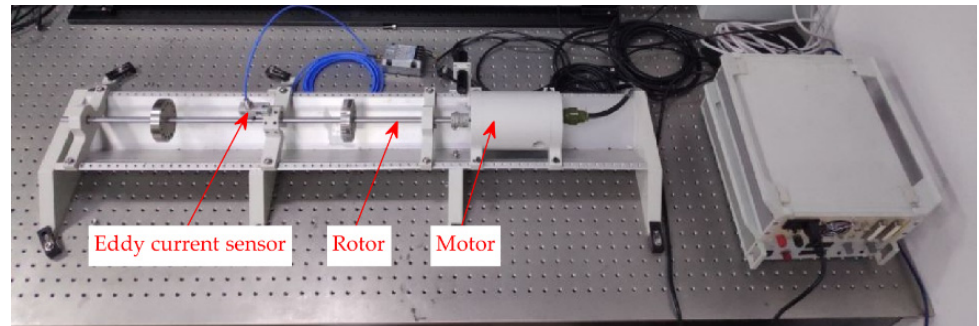
Figure 9. The rotor test rig.